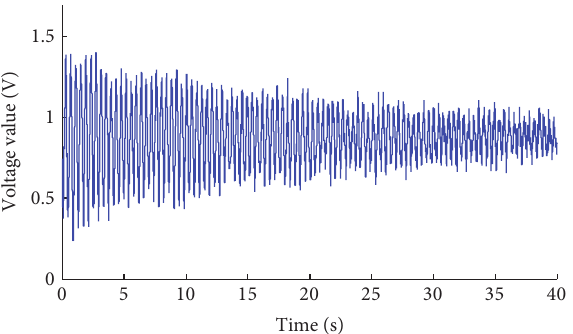
Figure 12: Piezoelectric time history of cable model free vibration.